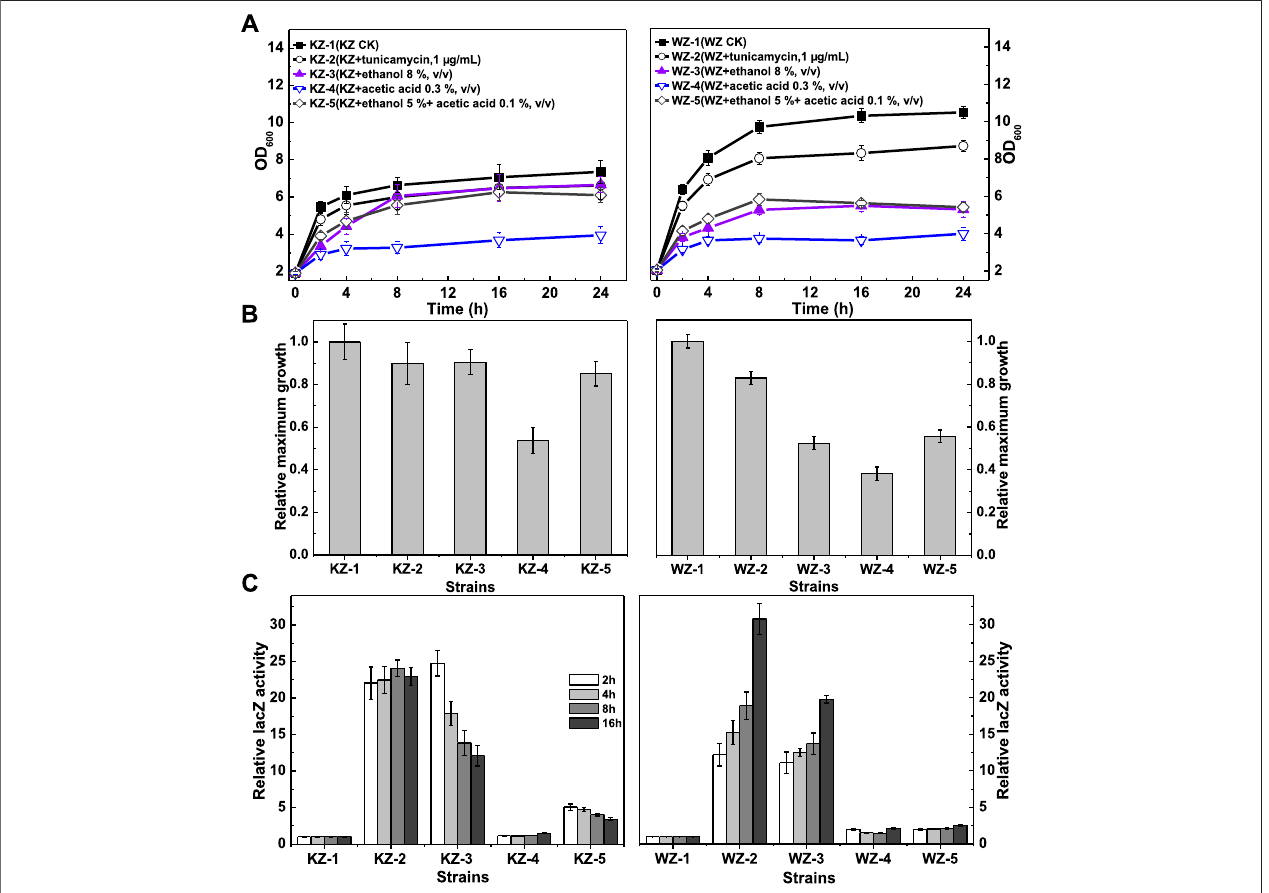
FIGURE 2 | The growth and β -galactosidase activity of strains KZ and WZ in the YPD medium with different additives. (A) The growth curve; (B) the ratio of maximum OD 600 value to that of controls KZ-1 or WZ-1; and (C) the ratio of β -galactosidase activity to that of controls KZ-1 or WZ-1. The original data was shown in Supplementary Material Table 1